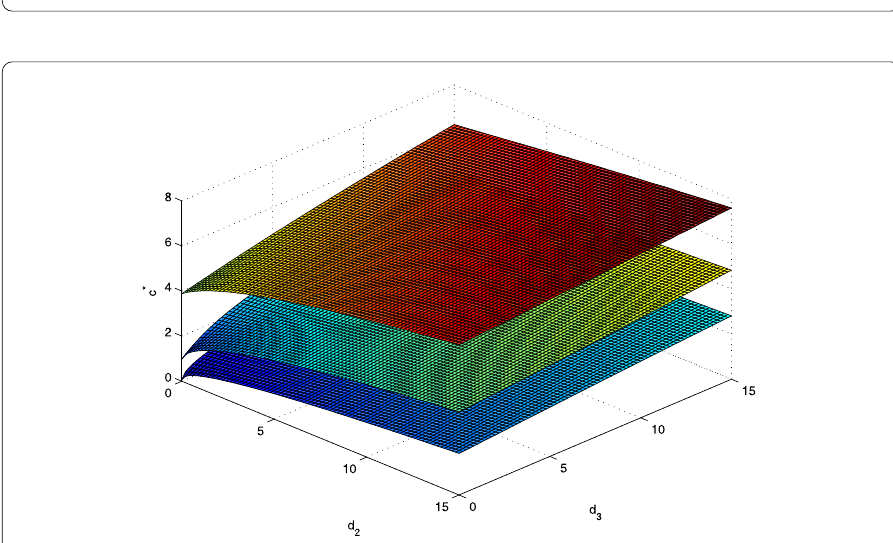
Figure 5 The surface of c ∗ ( d 2 , d 3 ) for the third model. Let α = 1, β = 3, S 0 = 1, γ = 1.5, and τ = 1 be fixed. Three surfaces from top to bottom are generated by taking ρ = 3,2,0.2, respectively. We can see that the surface of c ∗ increases as ρ